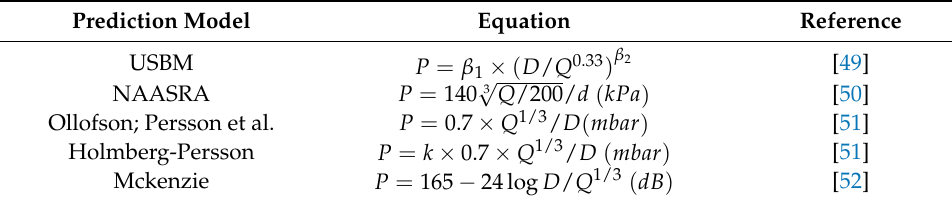
Table 4. Empirical models for predicting the airblast or air overpressure.